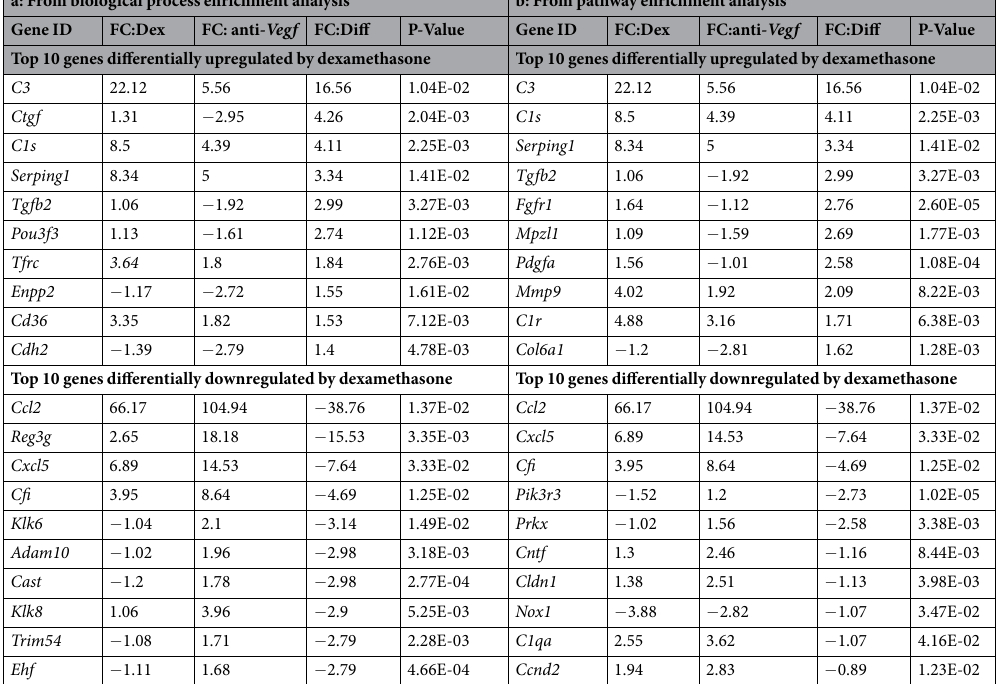
Table 1. The top 10 differentially up- and downregulated genes involved in selected biological processes (a), and in selected pathways (b). The abbreviation’FC Diff’ represents fold change in dexamethasone minus fold